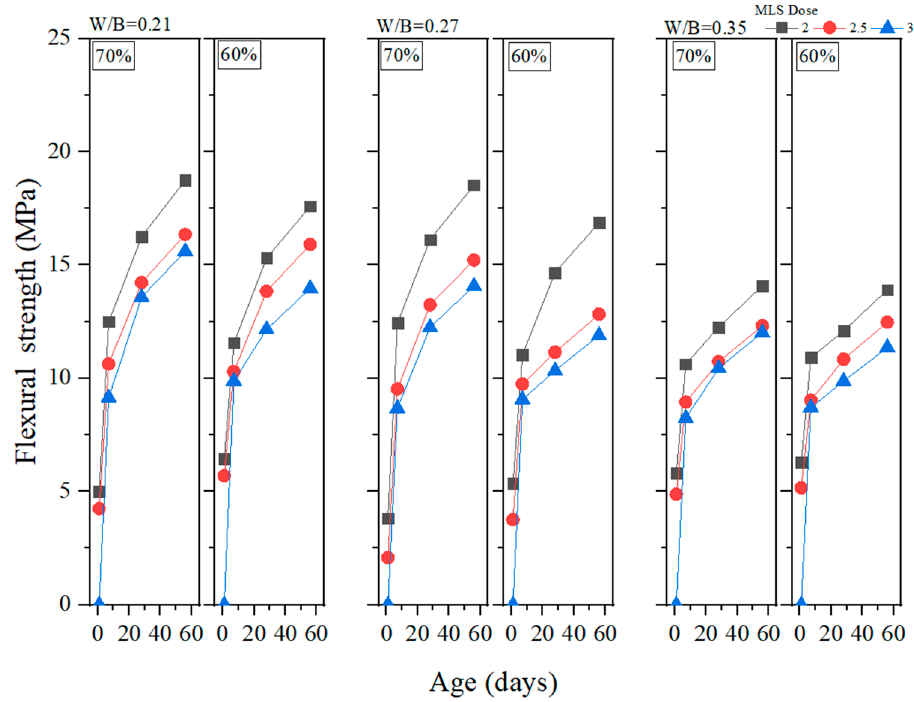
Figure 14. Flexural strength of green and ecofriendly grouting material with MLS.